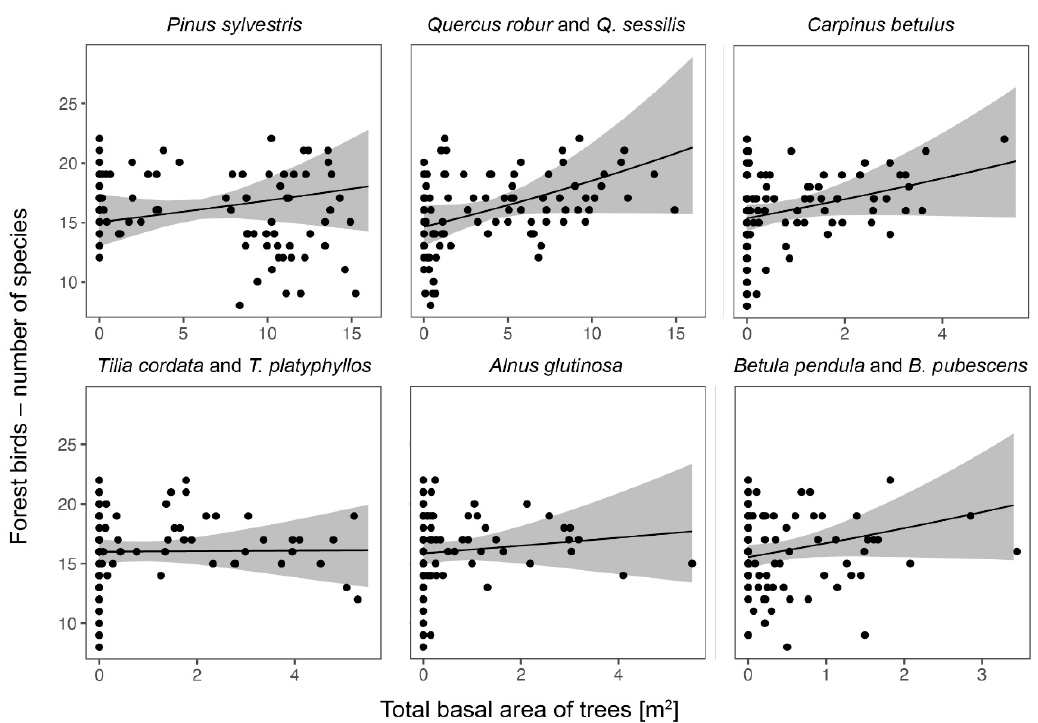
Figure 1. Relationships between species richness of forest birds (N/10 ha) and total basal area of trees thicker than 20 cm DBH (m 2 /0.45 ha), estimated using generalized linear models (GLMs) with log link function (Table 4). Dots represent measured values, line—prediction, gray area—95% confidence interval for prediction.